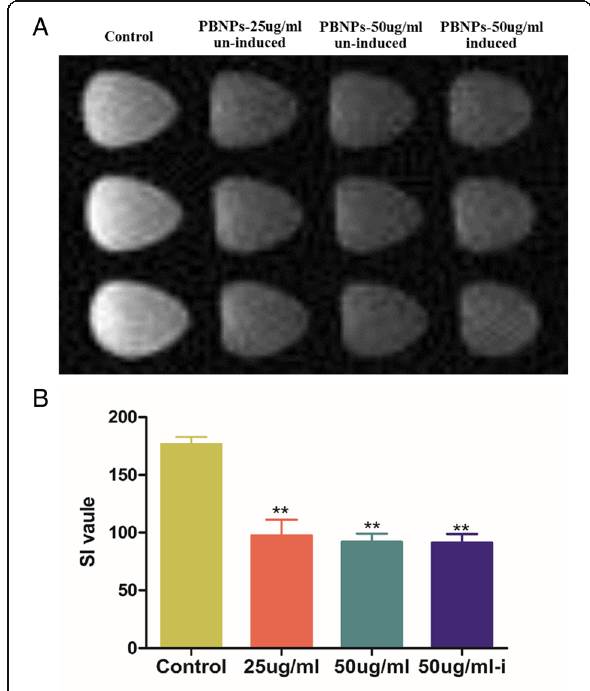
Fig. 9 T2-weighted MRI phantoms of MSCs. a Transverse section. b Quantitative analysis of SI value. ** P < 0.001 vs